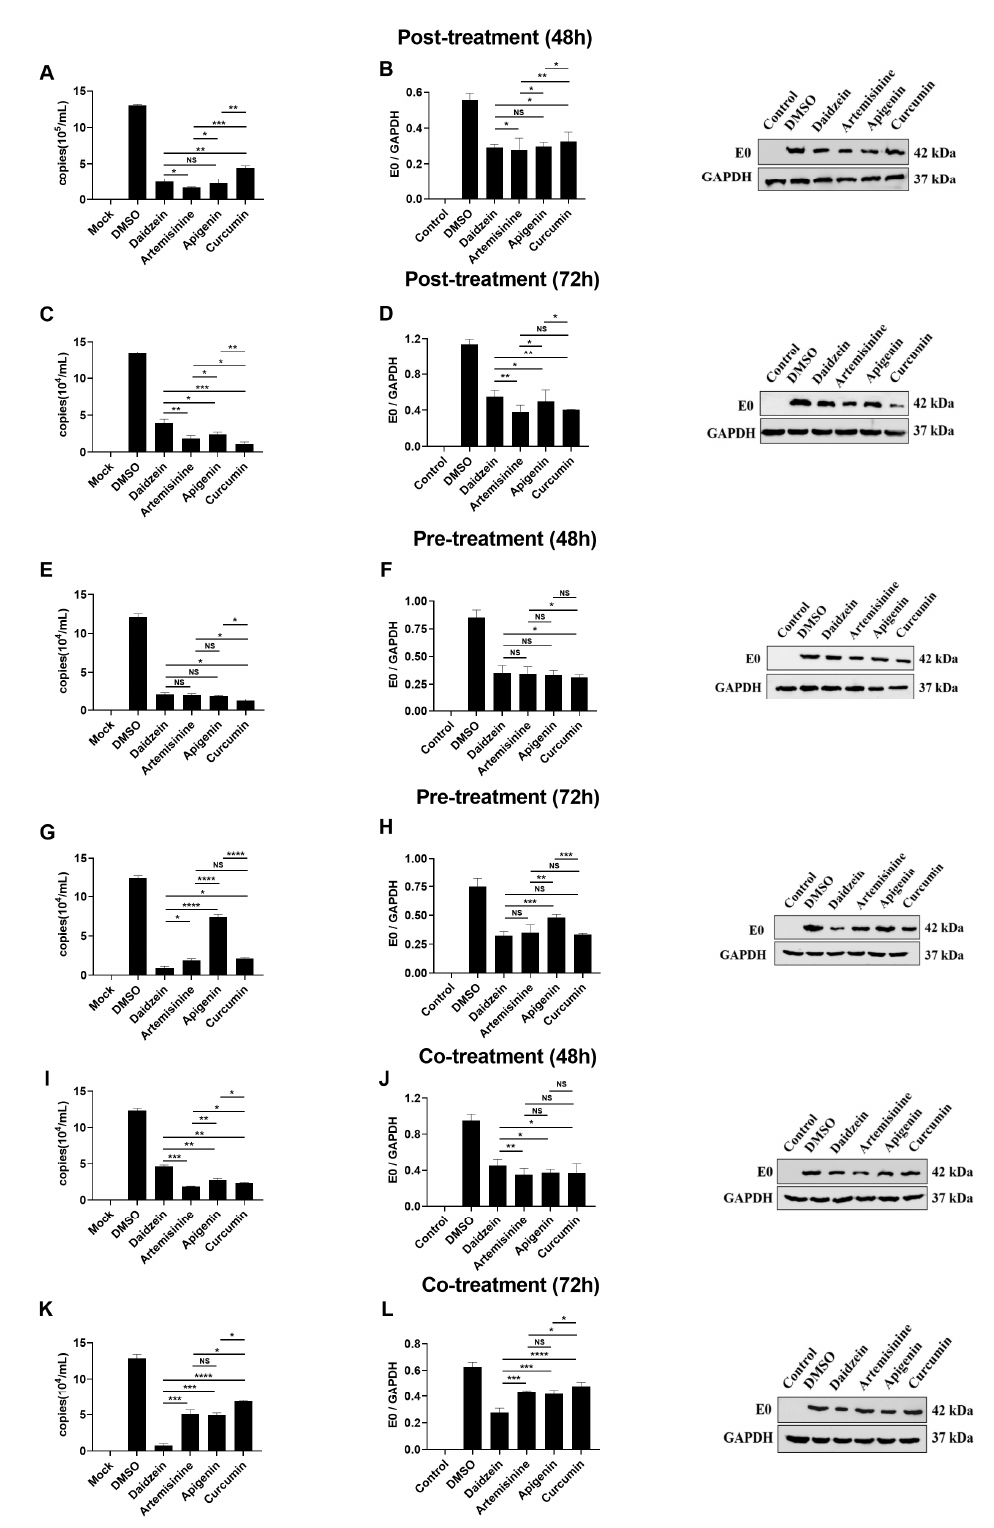
Figure 5. Results of Chinese herbal monomers on BVDV virus replication. ( A , B ): Viral mRNA and protein expression levels in MDBK cells after 48 h of BVDV inhibition using Chinese herbal monomers. ( C , D ): Viral mRNA and protein expression levels in MDBK cells after 72 h of BVDV inhibition